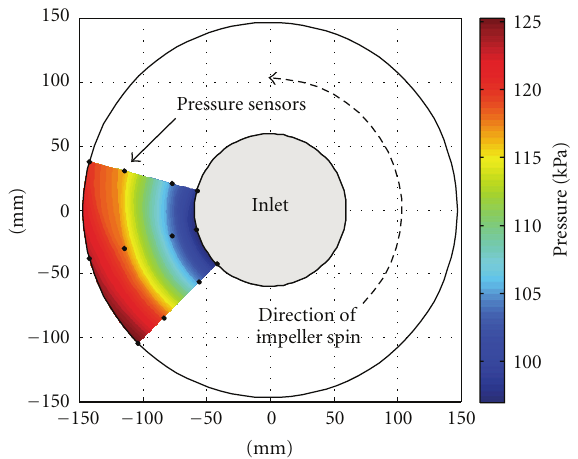
Figure 7: Experimental pressure map of the impeller region inside the compressor front casing, for the compressor operating at 16,290 rpm and 34% throttle valve opening. The measurement points of the twelve pressure transducers are marked by the dots in the map.